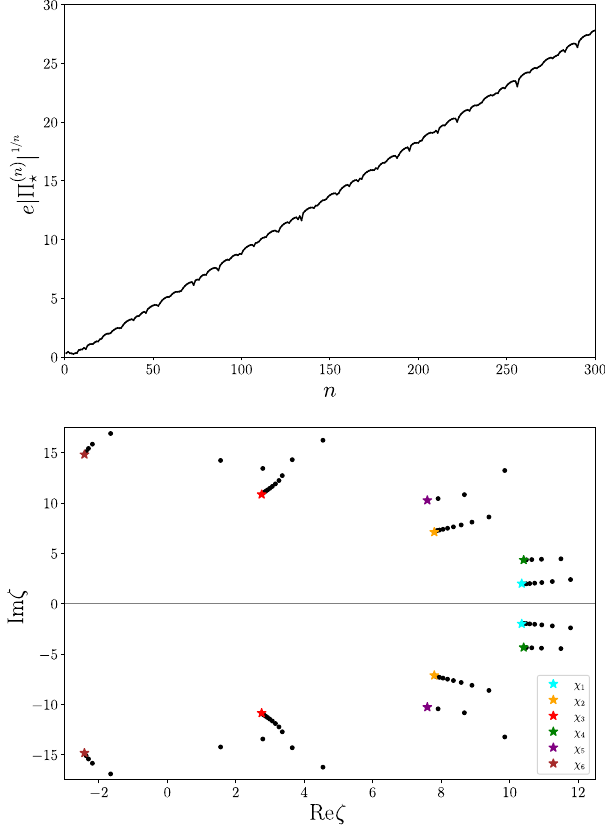
FIG. 3. Upper panel: large-order behavior of the gradient expansion at x ¼ 0 , t ¼ 0 . 5 for initial data of the form Eq. (28) as quantified by a root-test plot. The factorial growth is manifest. Bottom panel: singularities of the Pad´e approximant of the Borel transform of the gradient expansion at x ¼ 0 , t ¼ 0 . 5 . The points at which a line of pole accumulation starts are singulants and have been highlighted as stars. Cyan, orange, red, green, purple, and brown stars correspond to candidate singulant pairs χ 1 ; … ; χ 6 of progressively increasing